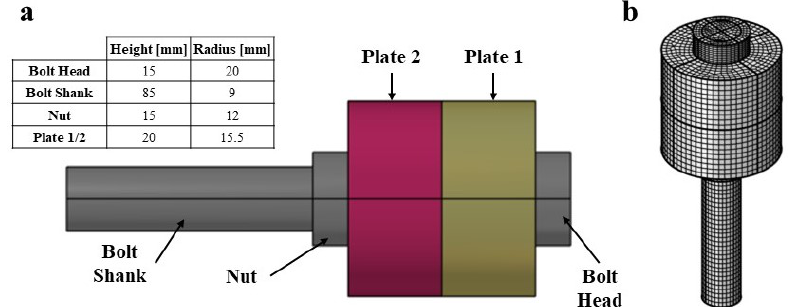
Figure 2. ( a ) Model of the M12 Bolt. ( b ) Meshed